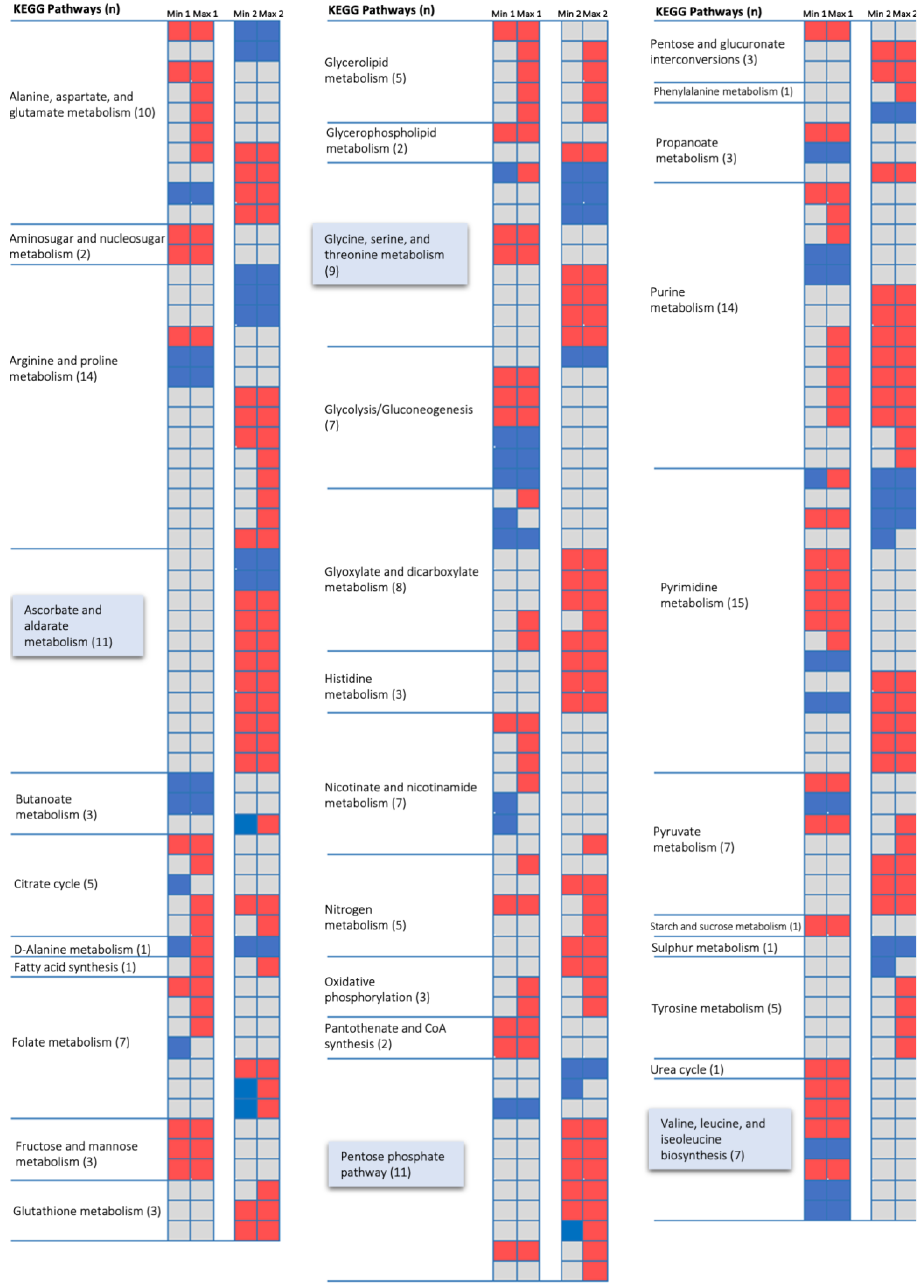
Figure 4. Detailed schematization of all altered reactions by using results of FVA. Red and blue colors Figure 4 represent the fluxes with positive and negative values, respectively. Gray represents no flux. Min 1, minimum flux in exponential condition; Max 1, maximum flux in exponential condition; Min 2, minimum flux in biofilm condition; Max 2, maximum flux in exponential biofilm. Highly altered pathways are highlighted in blue boxes; n is the number of reactions of the pathway that had flux for at least one